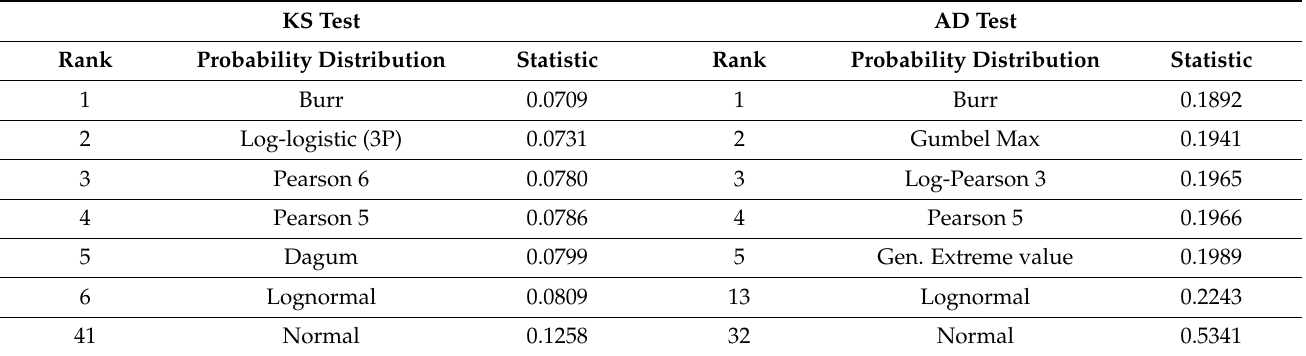
Figure 14. Probability density functions of normal and lognormal distribution under the ( a ) loading and ( b ) unloading conditions. Table 3. Result of goodness-of-fit test under loading